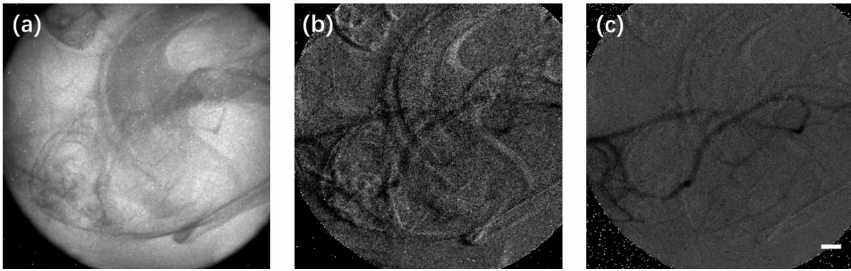
Figure 8 Experimental results obtained using an X-ray tube. ( a ) The primary projection of the cerebral microvessels. ( b ) Image obtained using the conventional temporal subtraction method. ( c ) Image obtained using the PTA method. Scale bar: 1